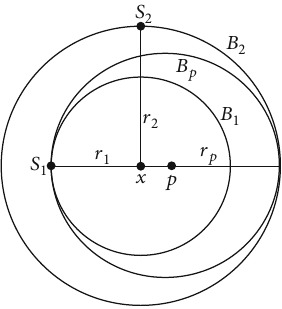
Figure 2: Hypersphere radius optimization